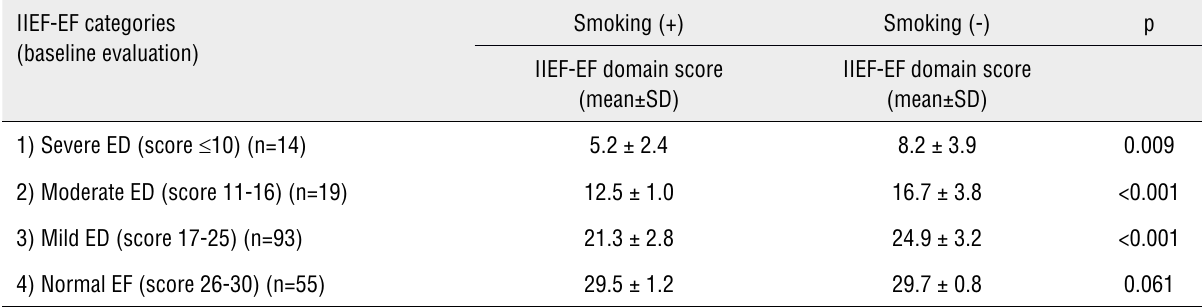
Table 3 - Comparison of the IIEF-EF domain scores of the IIEF-EF categories before and after smoking cessation. IIEF-EF